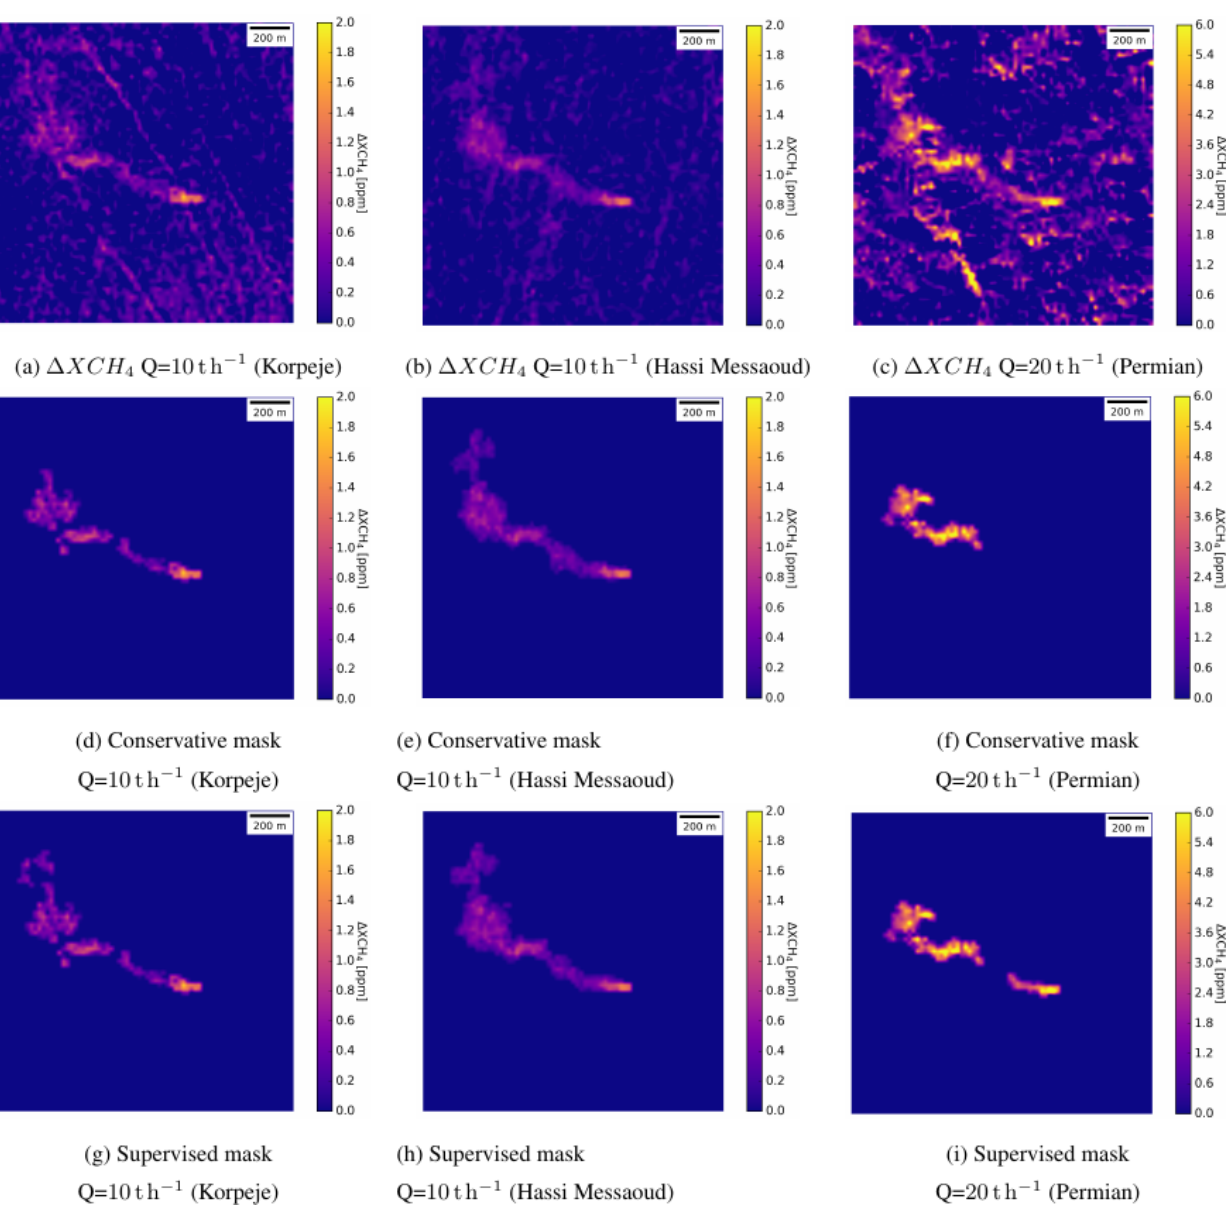
values (a, b, c) , the masked plumes obtained 4